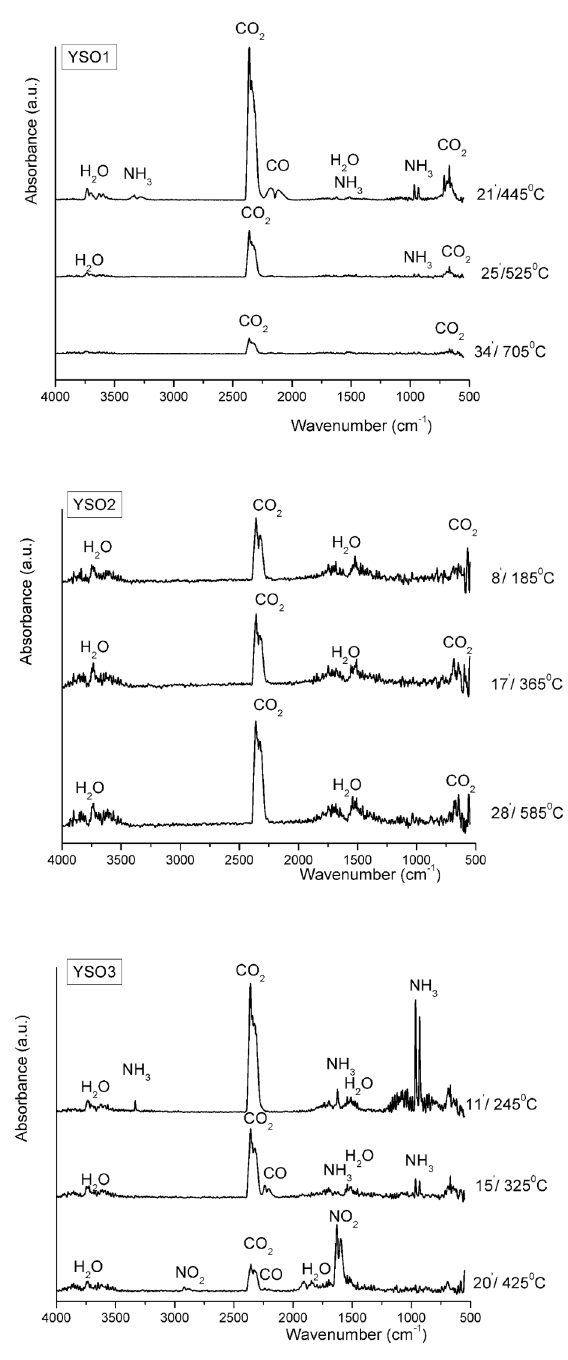
Figure 3. FT-IR spectra of gas evolved during the thermal treatment of